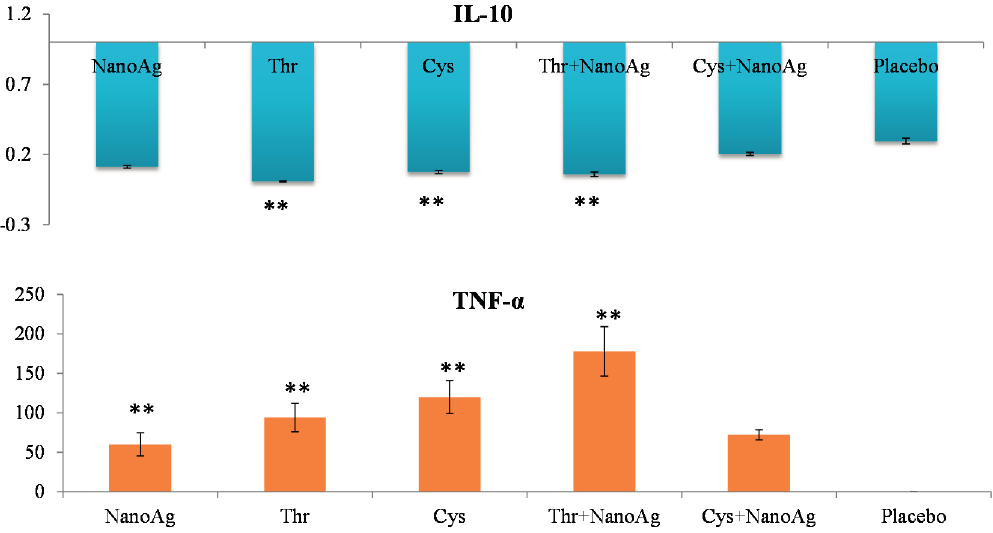
Figure 5. Relative fold expression level of interleukin-10 ( IL-10 ) and tumour necrosis factor-alpha ( TNF- α ) gene in spleen tissues of LPS induced in ovo NanoAg and/or amino acid injected embryos. Expression of uninjected control embryo is taken as 1.0. ** indicates significant expression at the level of 99% ( p < 0.01).